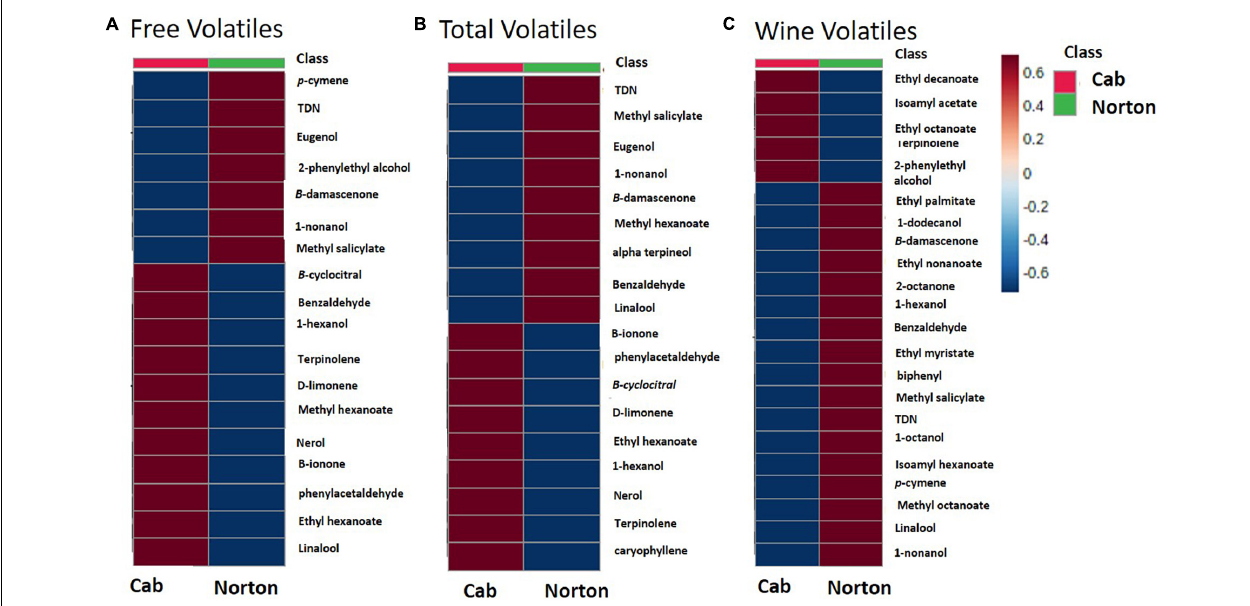
FIGURE 4 | Heatmaps of the abundance of the volatiles in Norton and Cabernet Sauvignon (Cab) (A) free volatiles, (B) total volatiles, and (C) wine volatiles. Heatmaps were created using average quantitative values based on 2-octanol IS. The rows in the heatmap represent volatile compounds and the columns indicate cultivars. The colors of the heatmap cells indicate the abundance of compounds across different samples. The color gradient, ranging from dark blue through white to dark red, represents low, middle, and high abundance of a compound,